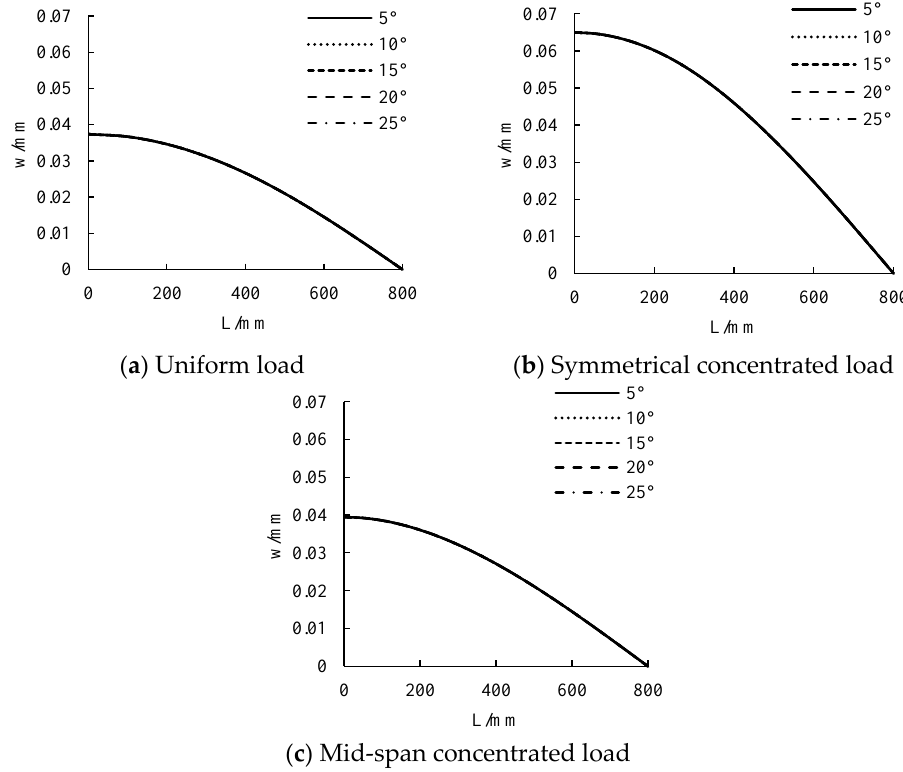
Figure 14. The influence of temperature on displacement.